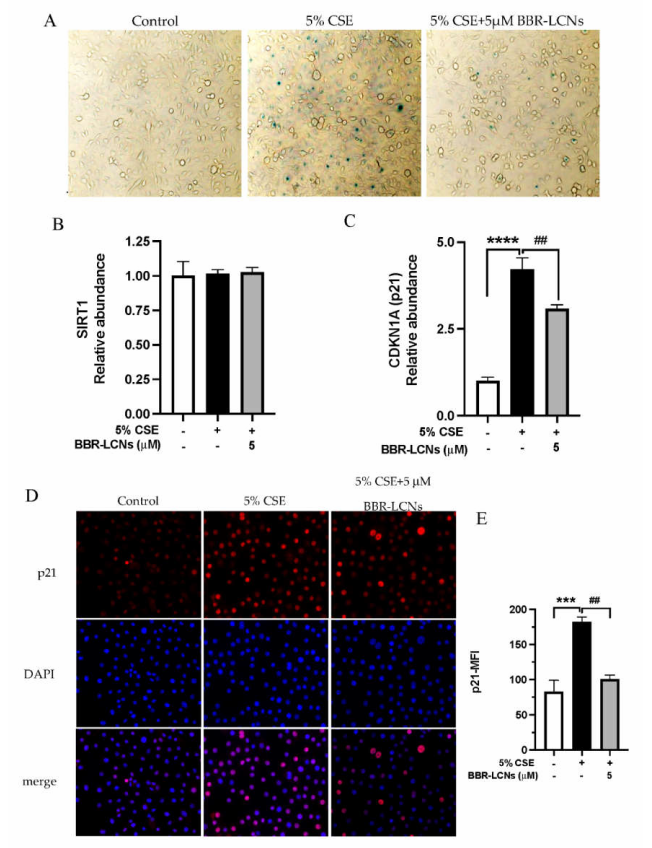
Figure 3. Effect of BBR-LCNs on 5% CSE-induced senescence of 16HBE. 16HBE cells treated with BBR-LCNs and 5% CSE for 24 h. ( A ) Cells were stained with b-galactosidase staining kit.